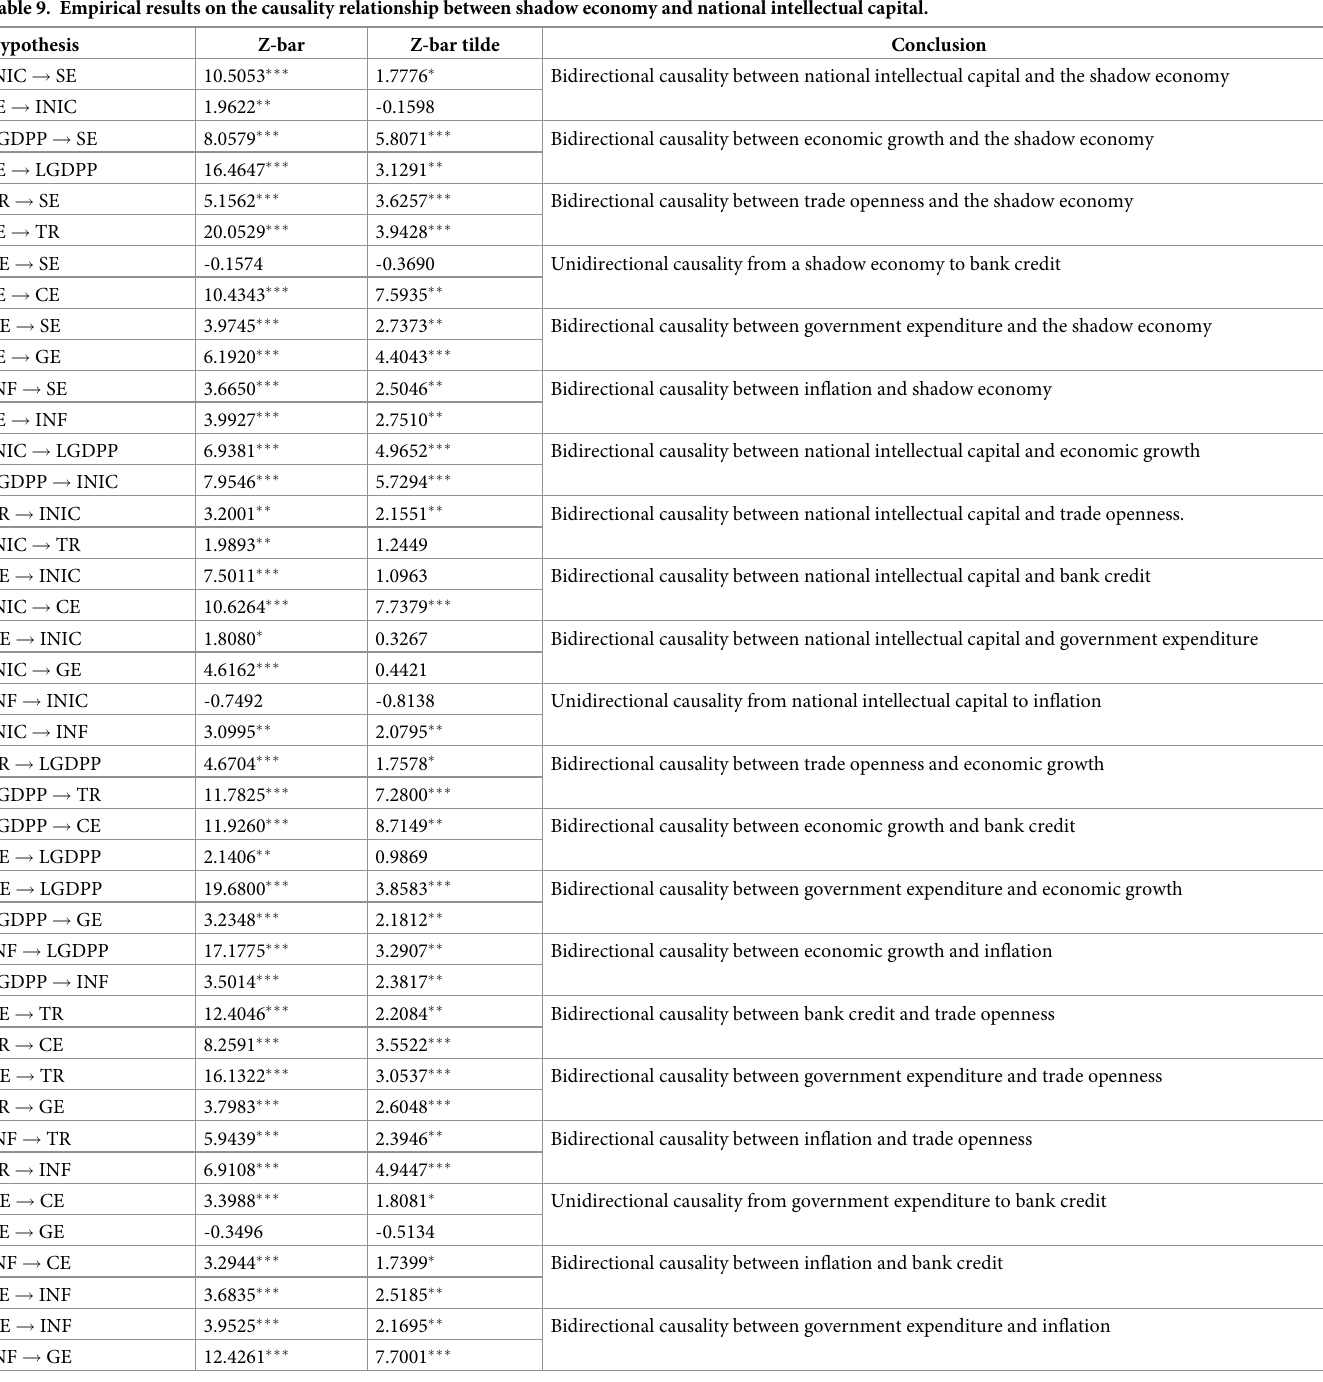
Table 9. Empirical results on the causality relationship between shadow economy and national intellectual